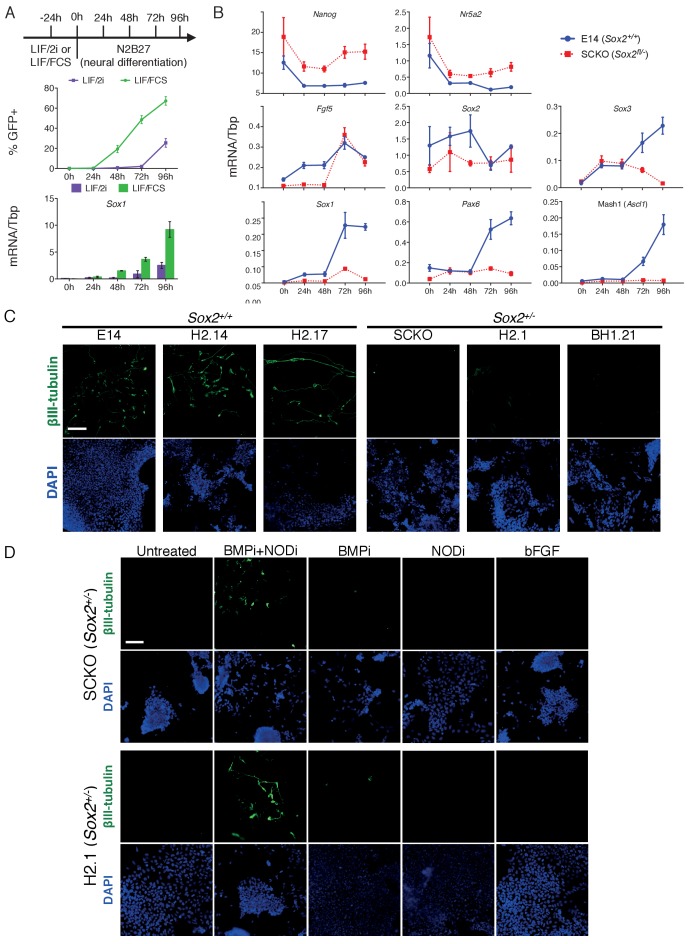
Decreased SOX2 levels prevent ESC differentiation into neurons.(A) (TOP) Schematic diagram showing experimental plan for neural differentiation. (MIDDLE) Sox1-GFP (Aubert et al., 2003) expression in 46C cells cultured in LIF/FCS (green) or LIF/2i (purple) and for the indicated number of hours in N2B27 neural differentiation medium were assessed by flow cytometry. The positive (+) gate was set above the GFP expression level observed in 46C ESCs. The error bars indicate the standard error of the mean (n = 4). (BOTTOM) RT-qPCR analysis of Sox1 mRNA level in 46C cells during neural differentiation. Error bars indicate the standard error of the mean (n = 2). (B) RT-qPCR analysis of the indicated transcripts in differentiating E14Tg2a (E14, Sox2+/+) and SCKO (Sox2fl/−) cells. Transcript levels were normalized to Tbp. Error bars represent standard error of the mean (n = 3). (C) Immunofluorescence staining of the neural marker βIII-tubulin (green) in Sox2+/+ E14Tg2a (E14), H2.14 and H2.17 ESCs, and in Sox2+/- SCKO, H2.1 and BH1.21 ESCs differentiated in N2B27 medium for 4 days; DAPI represented in blue. Scale bar, 100 μm. (D) Immunofluorescence staining of the neural marker βIII-tubulin (green) in Sox2+/-and H2.1 ESCs differentiated in N2B27 medium for 4 days in the presence or in the absence of the LDN-193189 BMP inhibitor (BMPi), of the SB-431542 Nodal inhibitor (NODi) and of recombinant bFGF; DAPI represented in blue. Scale bar, 100 μm.